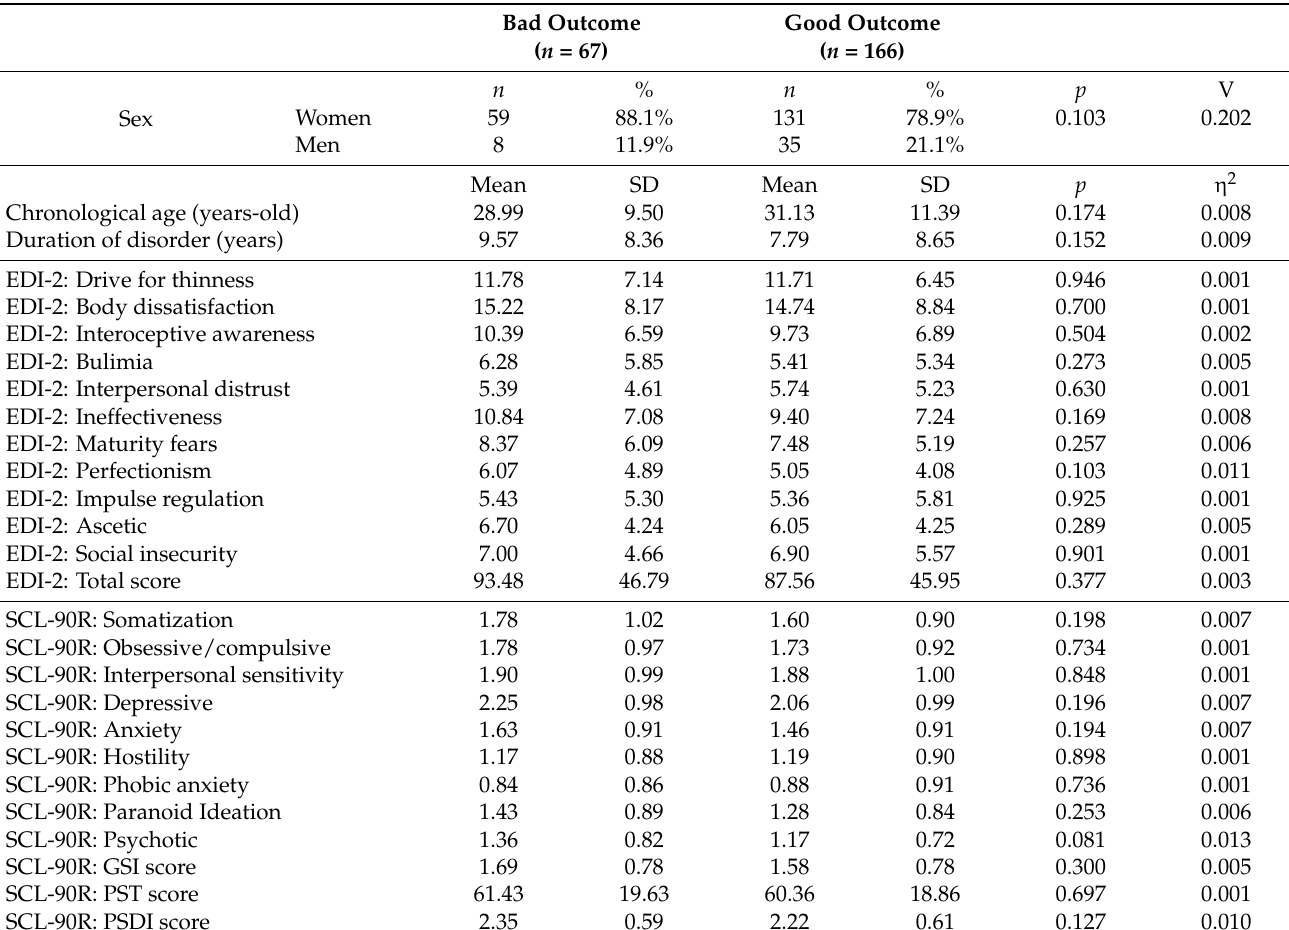
Table 3. Association between baseline measures with the cognitive–behavioral therapy outcome.